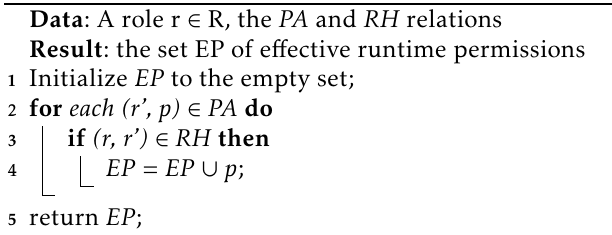
Algorithm EP : Obtaining the set of e ff